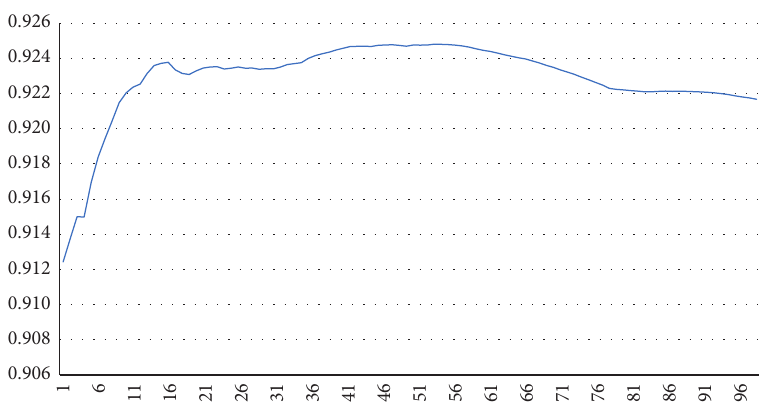
Figure 11: The visualization of R 2 score on KNN (distance) with K �